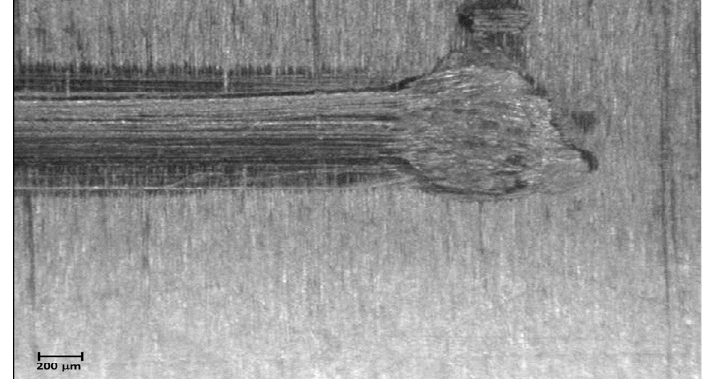
Figure 3: Sample 1, Piston, Longitudinal wear groove starting from one of the circular impressions.